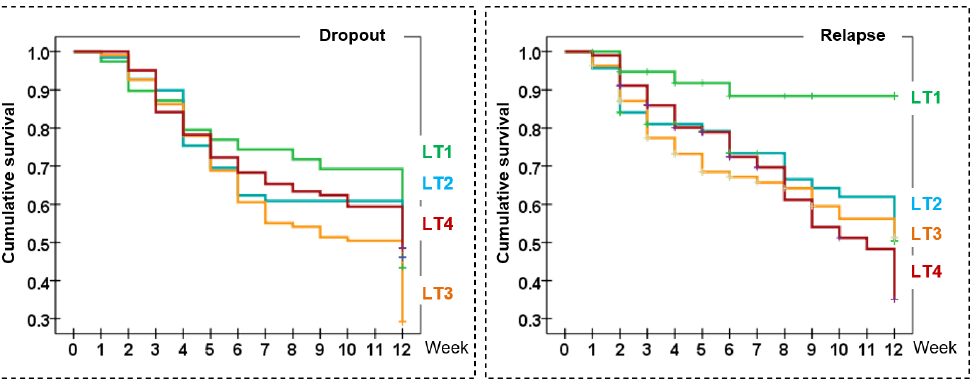
Figure 1. Kaplan–Meier functions for the incidence rate of dropout and relapse. Note. LT: latent class; LT1: good progression to recovery; LT2: middle progression; LT3: bad progression to dropout; LT4: bad progression to relapse.